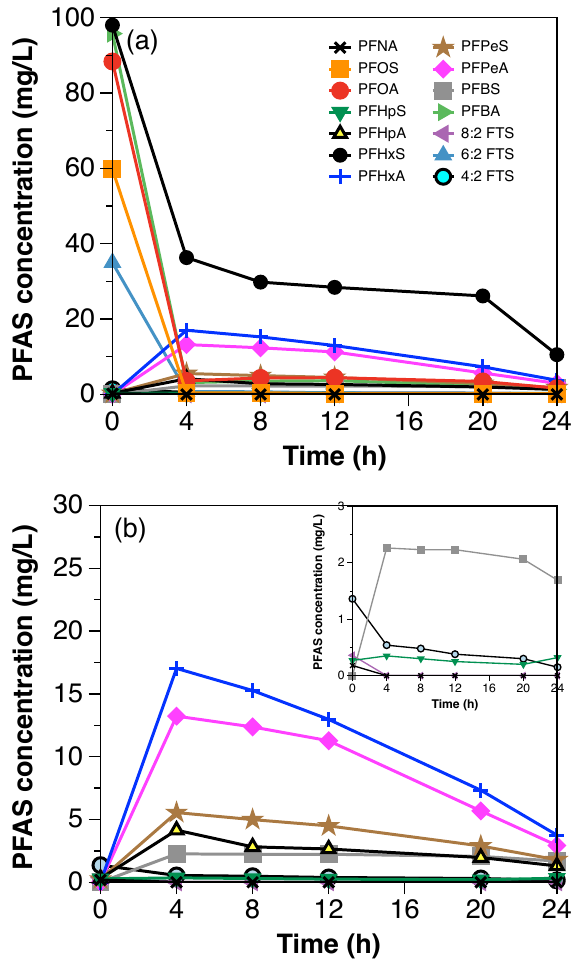
Figure 2. ( a ) Concentration of individual PFAS during the electrochemical treatment of a real still bottoms sample. The applied current density was 50 mA/cm 2 . ( b ) Concentration of individual PFAS with concentrations lower than 30 mg/L. Inset depicts the evolution of PFAS with concentrations lower than 3